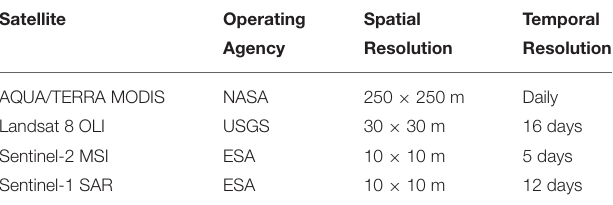
TABLE 1 | Remote sensing datasets used in this study.